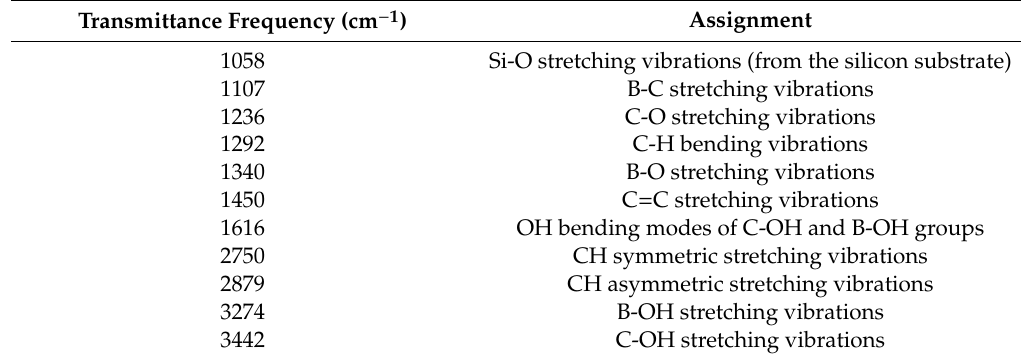
Table 3. Complete peak assignment for the FTIR spectral analysis of the BC-2 coating.